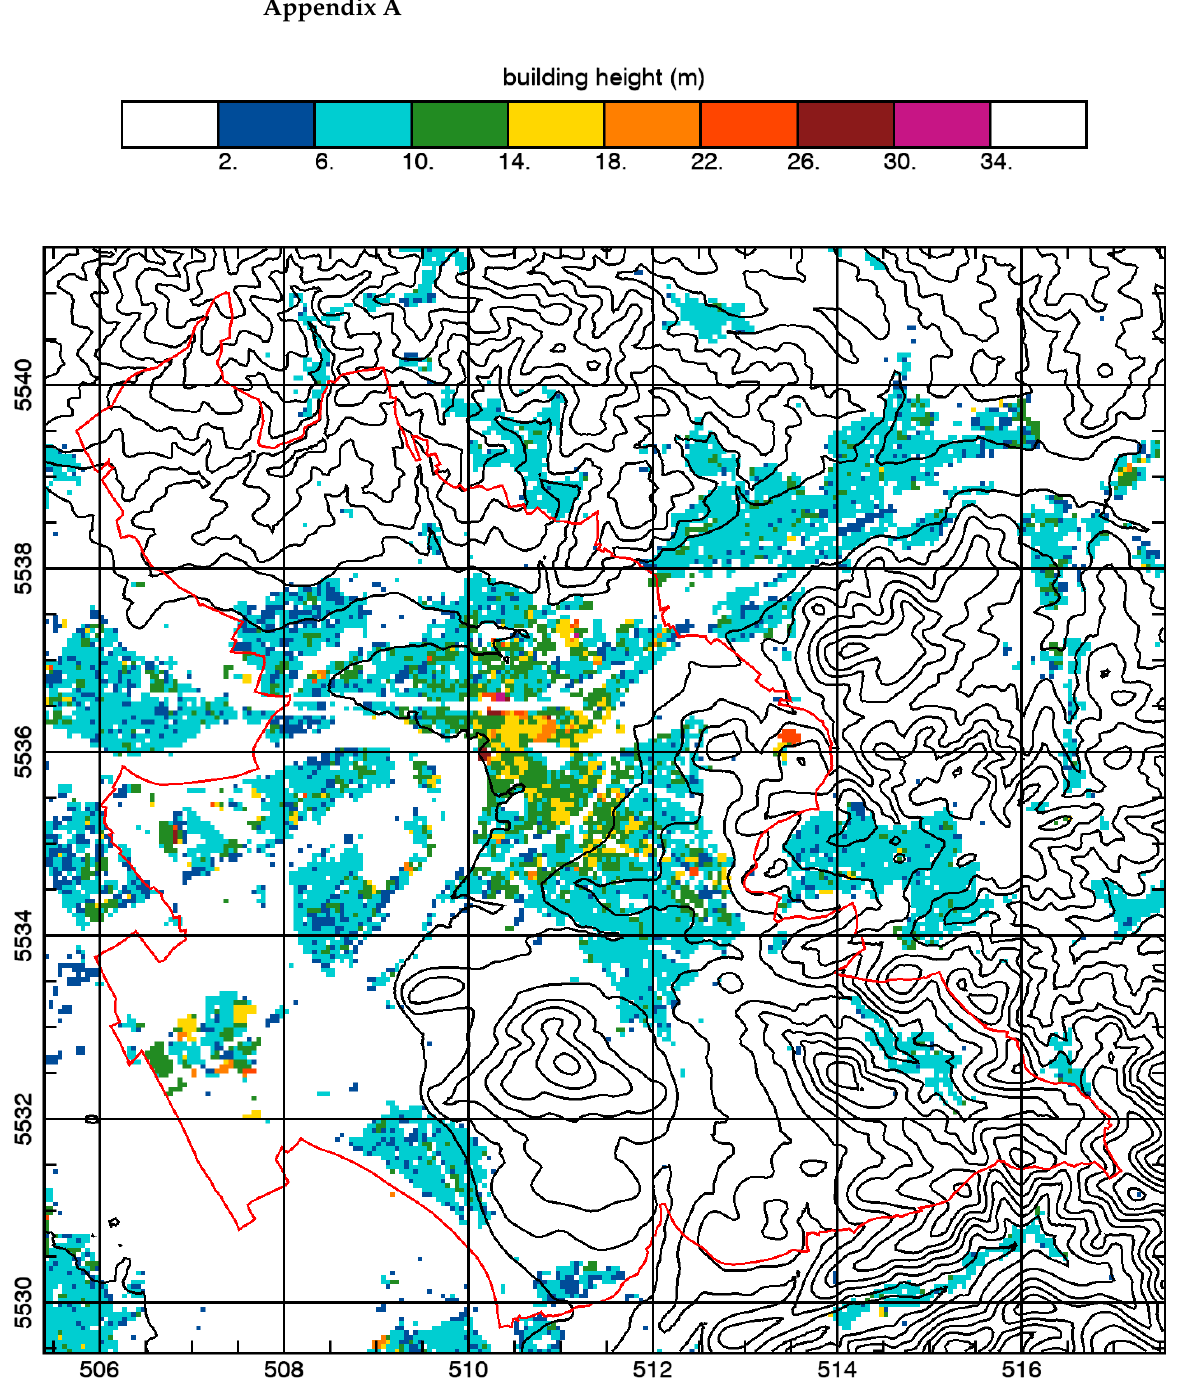
Figure A1. Map of building height in the 12 km × 12 km city subdomain, the terrain elevation contour lines in black and the city border of Aschaffenburg in red [30].